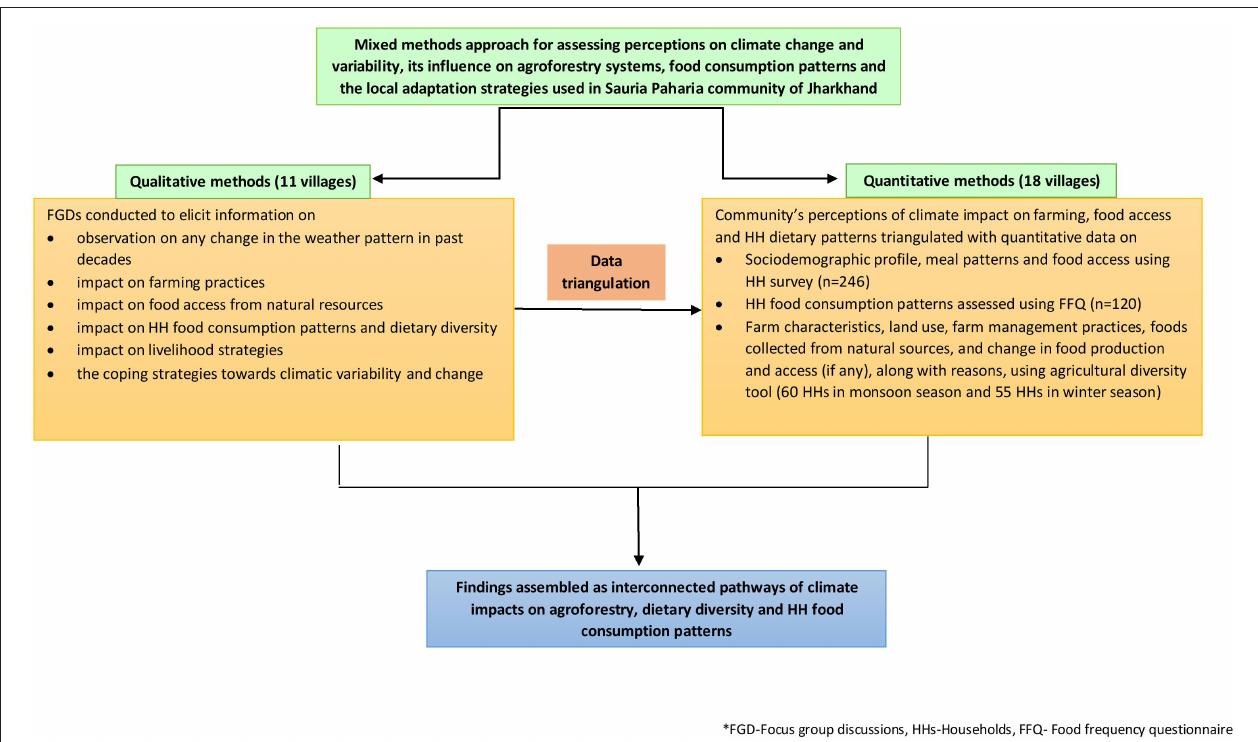
FIGURE 2 | Methodological approach used in the present study.